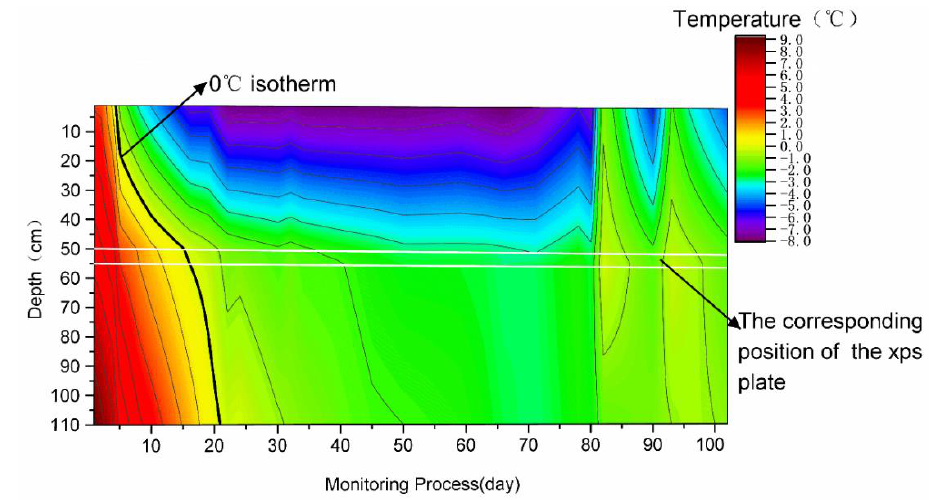
Figure 4. Temperature distribution map of the subgrade without a cold resistance layer.